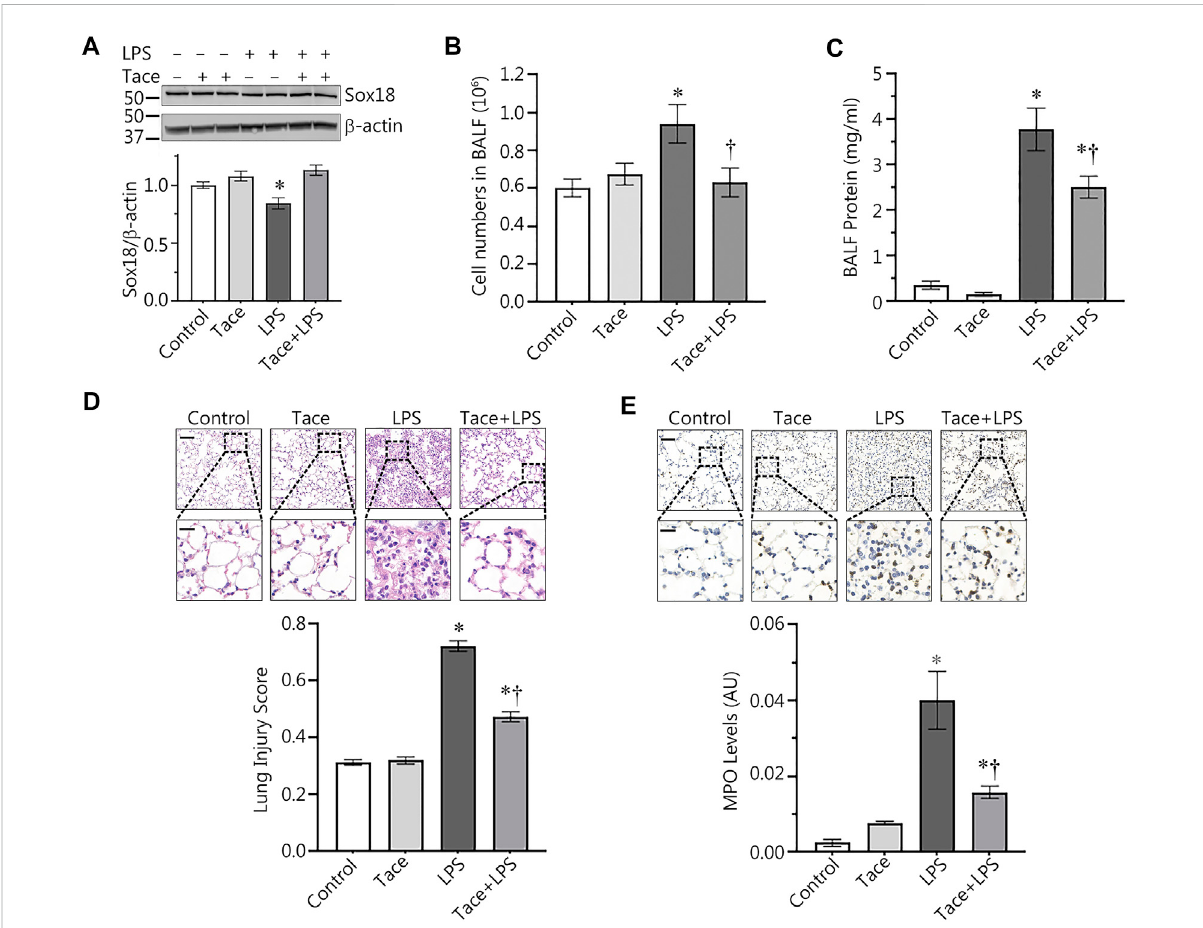
FIGURE 6 HDAC1inhibitionattenuatesALIinthemouse.MicewerepretreatedwithtacedinalinebeforebeingexposedtoLPS.Pharmacologicalinhibition of HDAC1 by tacedinaline preserves Sox18 protein levels (A) and protects the pulmonary endothelial barrier as demonstrated by decreases in the numberofin fl ammatorycells (B) andproteinconcentration (C) intheBALF.LungsectionswereH&Estained,examinedforsignsofin fl ammation (D) , representative images shown) and scored for lung injury. The mice treated with tacedinaline had a lower lung injury score. Myeloperoxidase (MPO) immunostaining of the lung sections demonstrated a presence of activated neutrophils in the lungs exposed to LPS. Tacedinaline pre- treatment signi fi cantly decreased a number of neutrophils (E) . Data are mean ± SEM, n = 4 – 12. * p < 0.05 vs . Control; † p < 0.05 vs . LPS